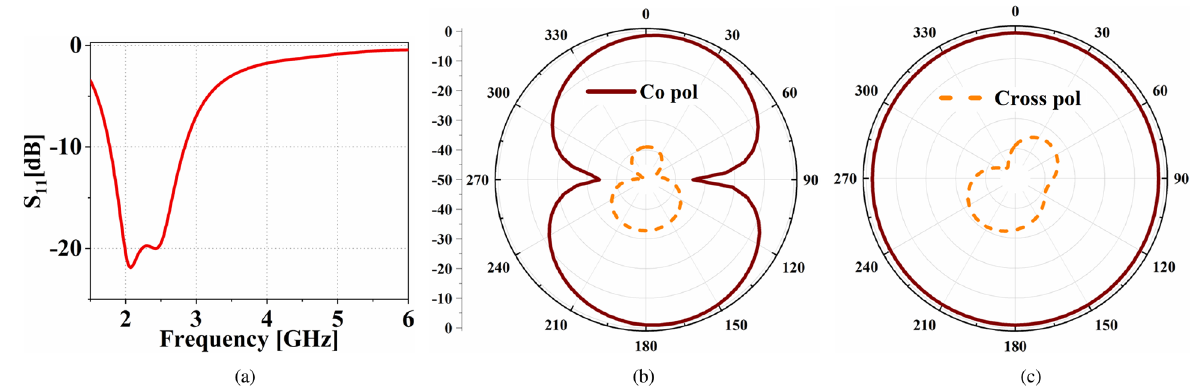
Figure 6. ( a ) Input reflection coefficient of the proposed fixed band communication antenna.The simulated radiation pattern of the antenna at 2.45 GHz in ( b ) phi = 0 ◦ , ( c ) phi = 90 ◦